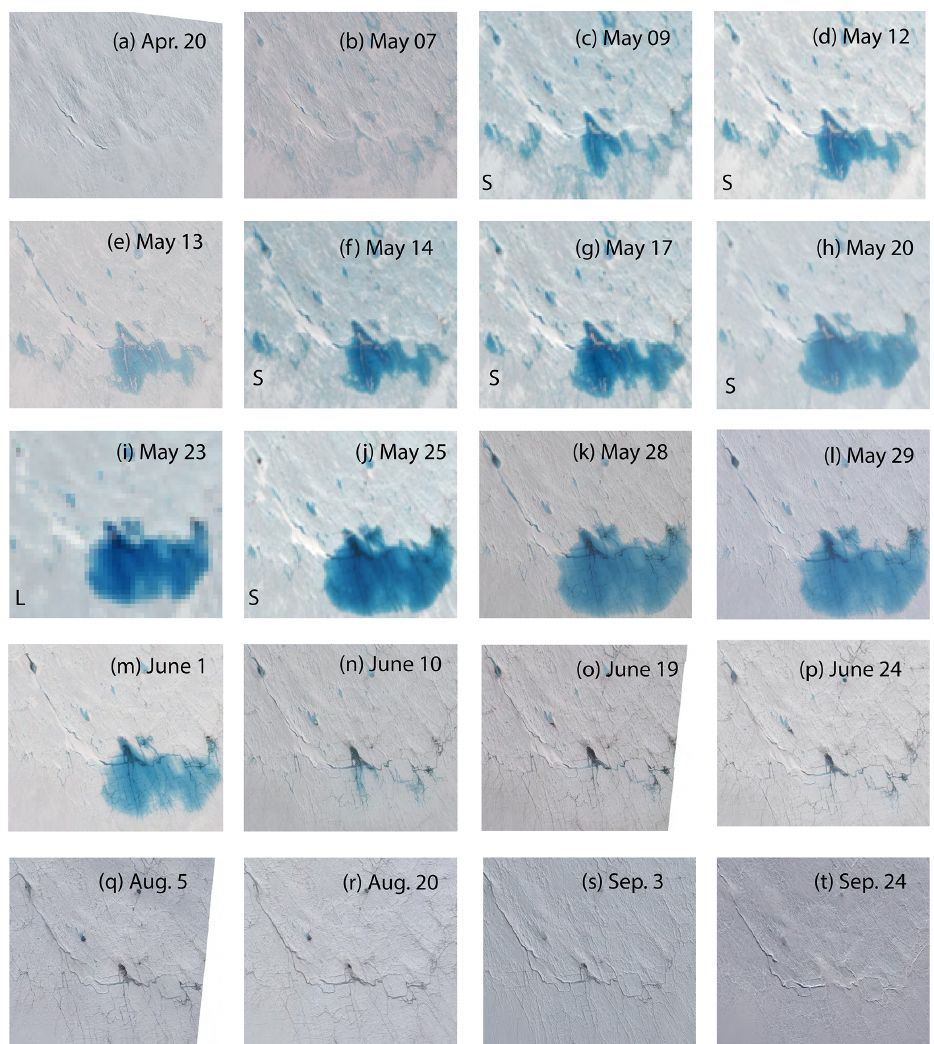
Figure 8. Imagery over Lake Julian shown from 20 April through 24 September 2019. All images use Planet SkySat Visual data unless otherwise indicated by letter on bottom left, with S indicating Sentinel and L indicating